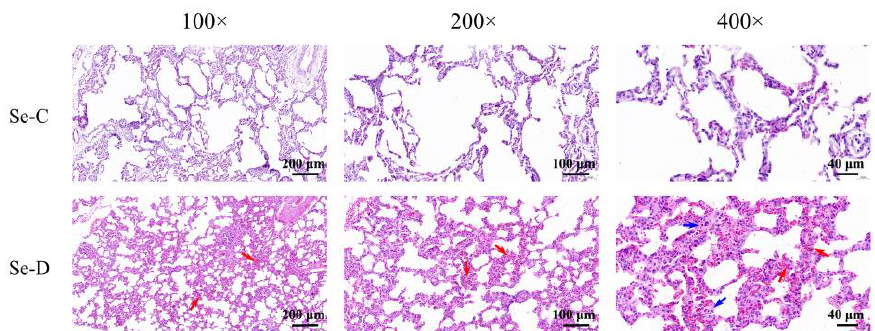
Figure 2. Pathological changes in the lungs of Se-deficient calves ( lower ) compared with healthy calves ( upper ) in pathological histological examination. Red arrows mark pulmonary congestion and blue arrows mark inflammatory infiltrates.